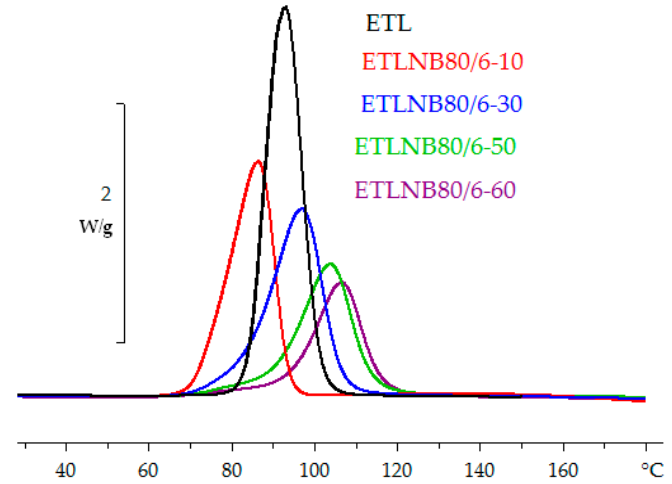
Figure 6. Non-isothermal DSC cure curves for ETL (black), ETLBN80/6-10 (red), ETLBN80/6-30 (blue), ETLBN80/6-50 (green), and ETLBN80/6-60 (purple) at the heating rate of 5 K/min. Exothermic direction is upward. The peak height decreases with increasing BN content.